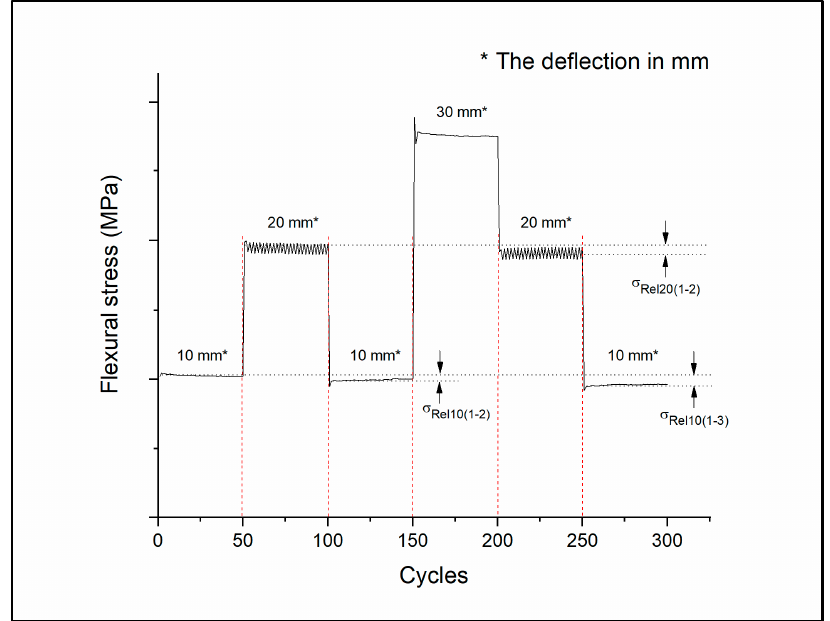
Figure 4. The scheme for variable load cyclic test method. The figure represents how the specimens were bent to a specified value for 50-50 cycles. In the first stage, the deflection was 10 mm, then 20 mm, 10 mm, 30 mm, 20 mm, and 10 mm again. The black dotted lines show flexural stress at 10 mm and 20 mm deflection and the relative changes in stress are illustrated by the arrows.